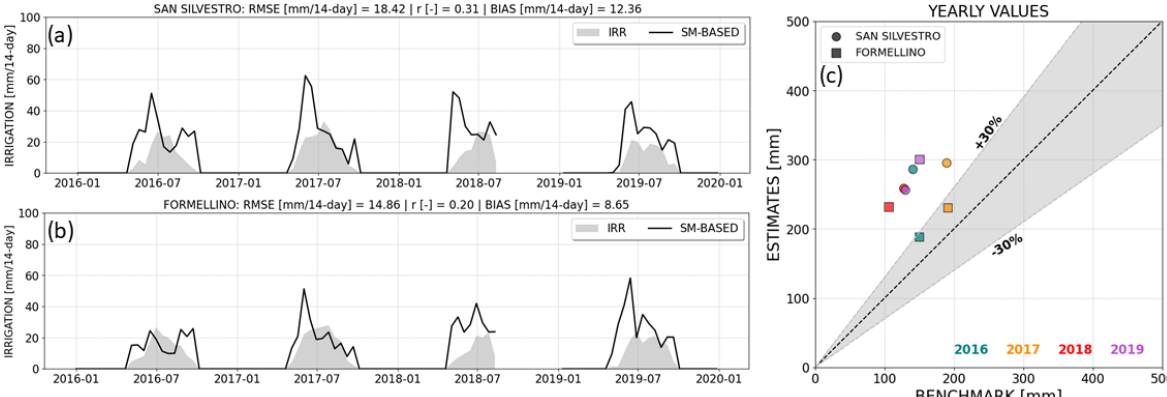
Figure 7. (a–b) The 14d aggregated time series of irrigation estimates (the black lines) over the two considered pilot districts within the Po valley against the benchmark rates (the light grey shaded areas). (c) Yearly comparison with data referring to different districts and years indicated through different markers and colors, respectively. The interval indicating a relative error of ± 30% is shown as